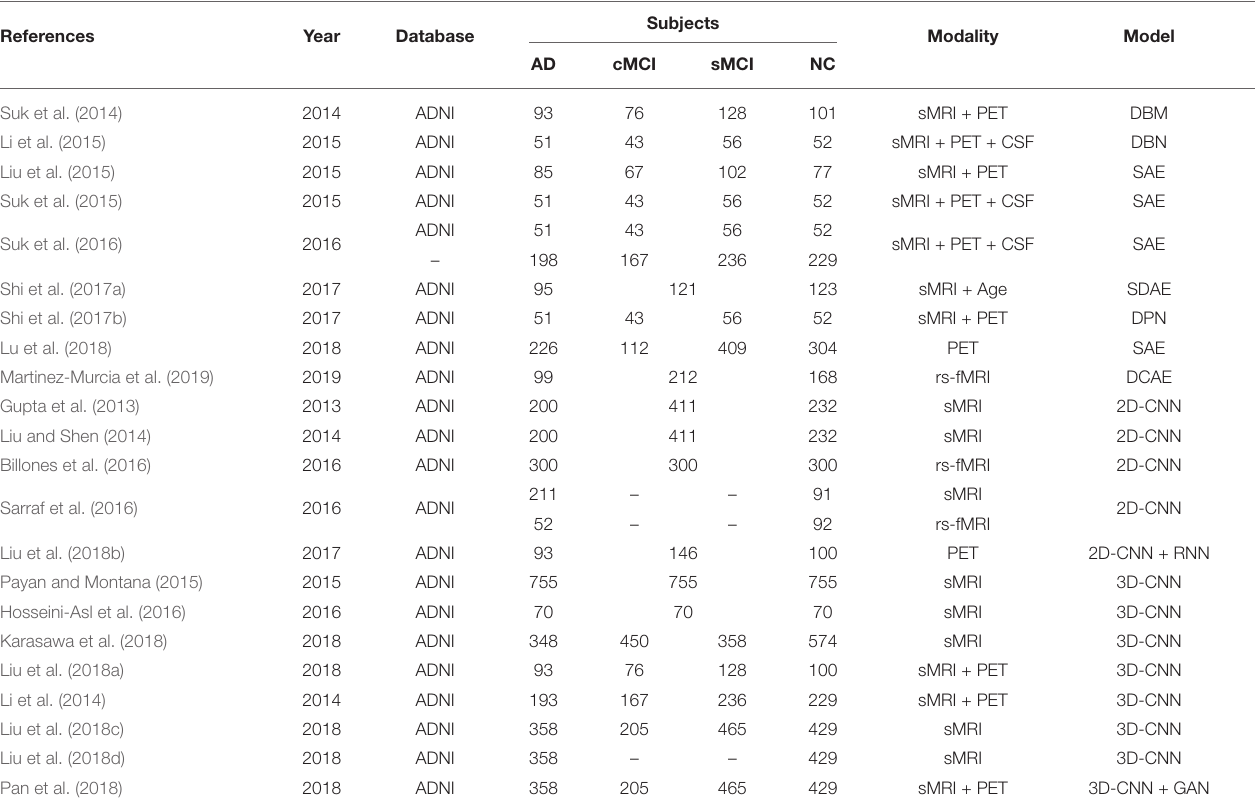
TABLE 1 | Overview of papers using deep learning techniques for AD